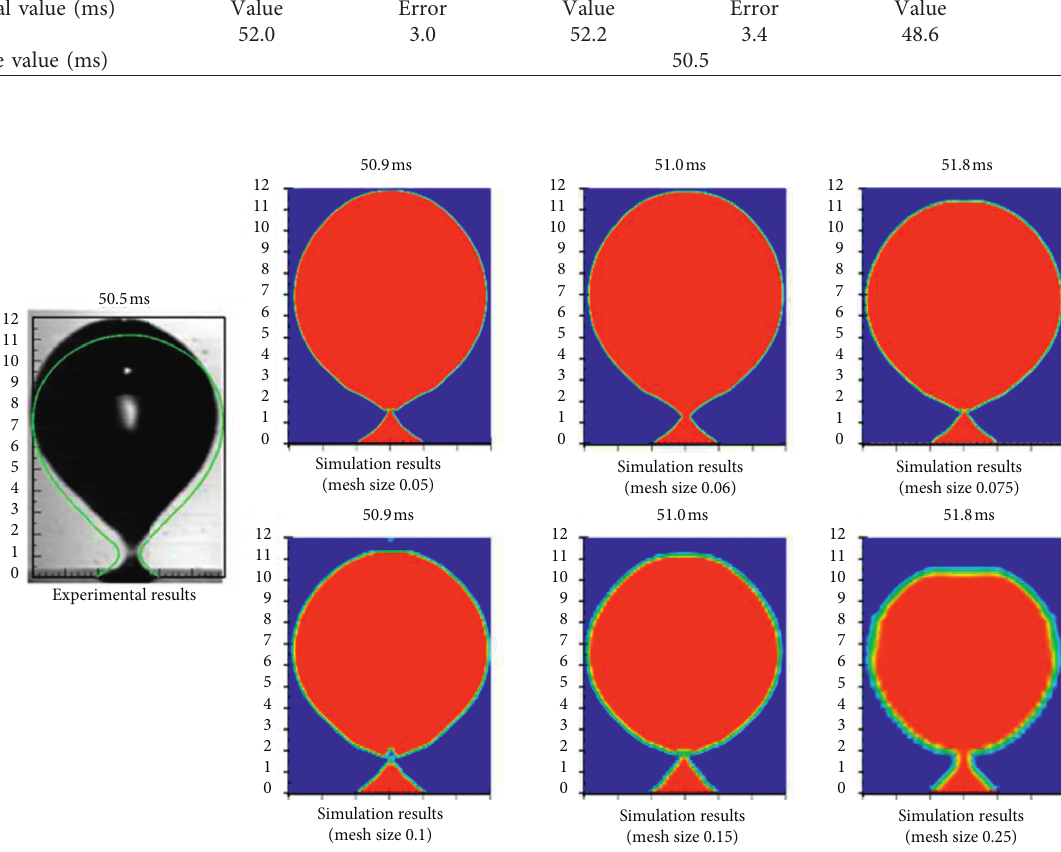
Figure 17: Simulation snapshots at detachment time for different mesh sizes [54].